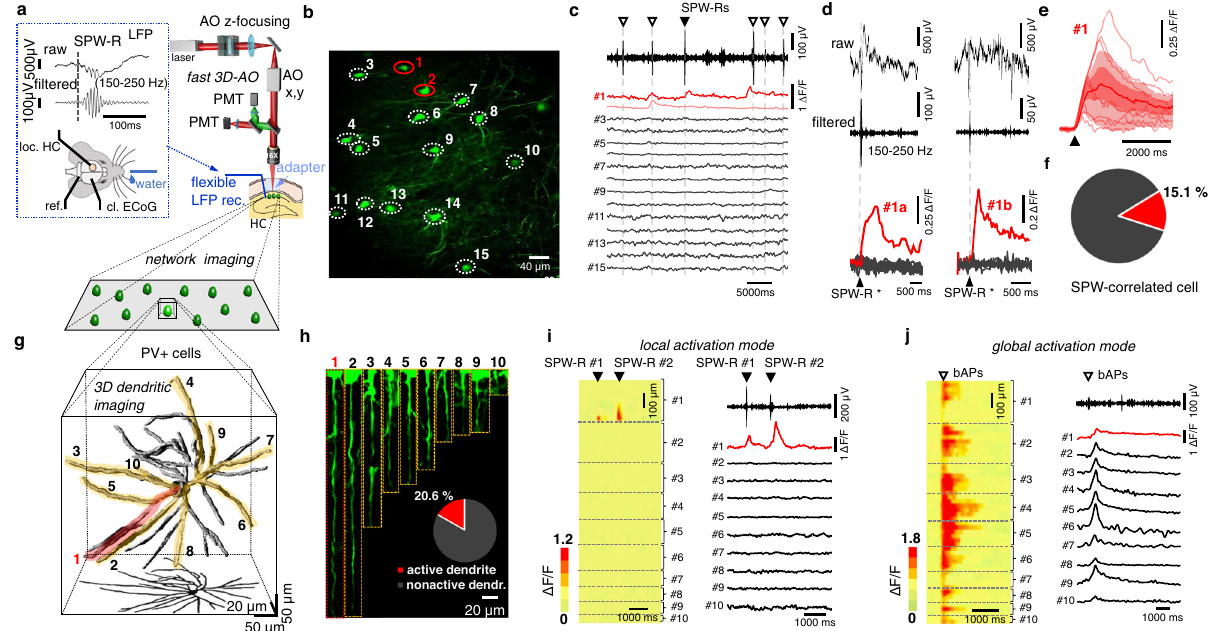
Fig. 1 | Activation of long dendritic segments revealed by fast 3D imaging in SPW-R-associated PV+ cells in behaving mice. a Schematic of the combined LFP recording, fast raster scanning, and 3D dendritic measurements with AO micro- scopy ( g ) during SPW-Rs in the periods of water licking. Inset, representative raw and fi ltered local hippocampal LFP signals with an SPW-R event from the stratum pyramidale from the ipsilateral hippocampus. Bottom panel indicates the position of the local hippocampal (loc. HC), reference (ref.) and contralateral cortical (cl. ECoG.). b Red and white dashed circles indicate PV+ neurons in the CA1 region of the hippocampus, which were active and inactive, respectively, during SPW-Rs. c Local LFP signal and somatic Ca 2+ responses recorded simultaneously to b . Arrowheads indicate SPW-R events. Red traces indicate SPW-R-associated somatic responses. d Left raw, enlarged view of the SPW-R (#1a) event indicated with fi lled arrowhead in c is shown with and without fi ltering with corresponding somatic responses. Right raw, same as left raw, but with another event (#1b). e Individual SPW-R-associated Ca 2+ transients from cell #1 overlaid with the average